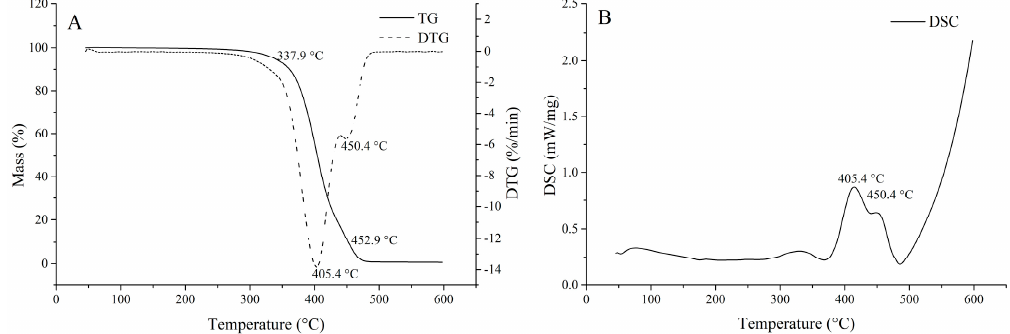
Figure 3. ( A ) Thermal gravity (TG)/differential thermogravimetry (DTG) and ( B ) differential scanning calorimetry (DSC) curves of fenugreek seed oil obtained by SBE.